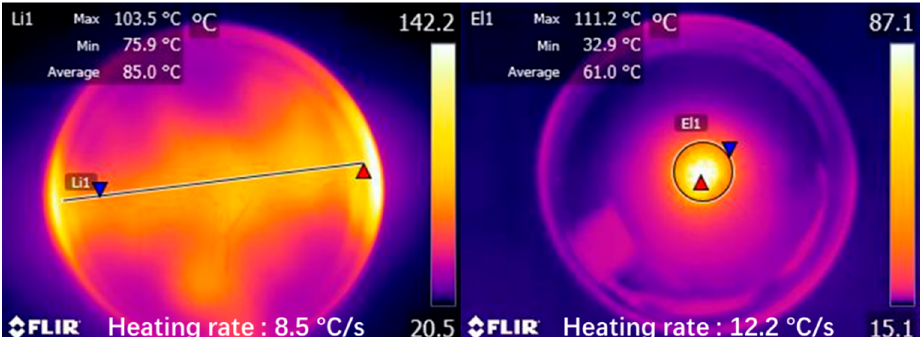
Figure 11. Infrared images of Dramix steel fibers and steel wool fibers after induction heating.